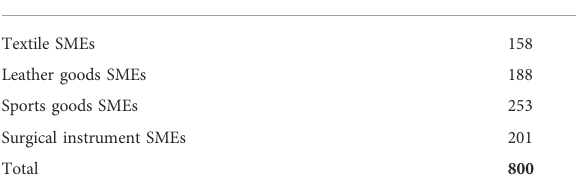
TABLE 2 Industry-wise sample size based on population proportionate.